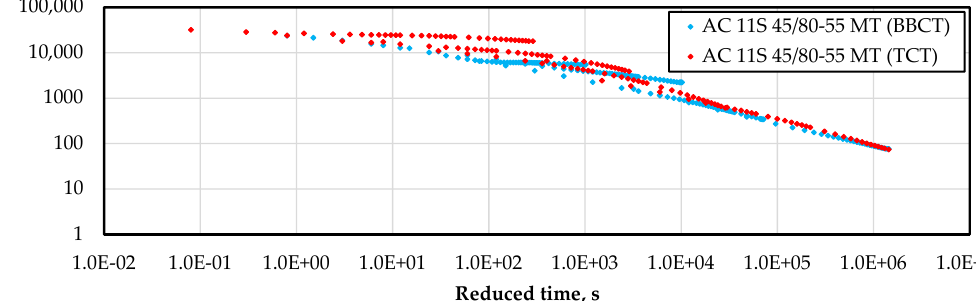
Figure 12. Comparison of shifted stiffness curves for AC 11S 50/70 MT, reference temperature: − 10 °C.